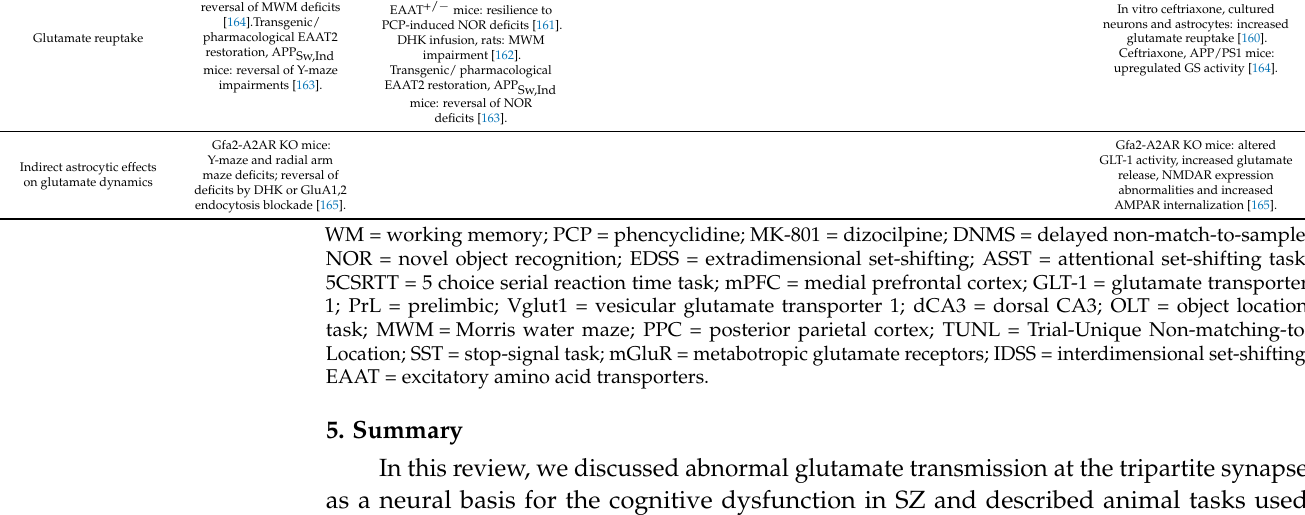
Gfa2-A2ARKOmice: Y-mazeandradialarm